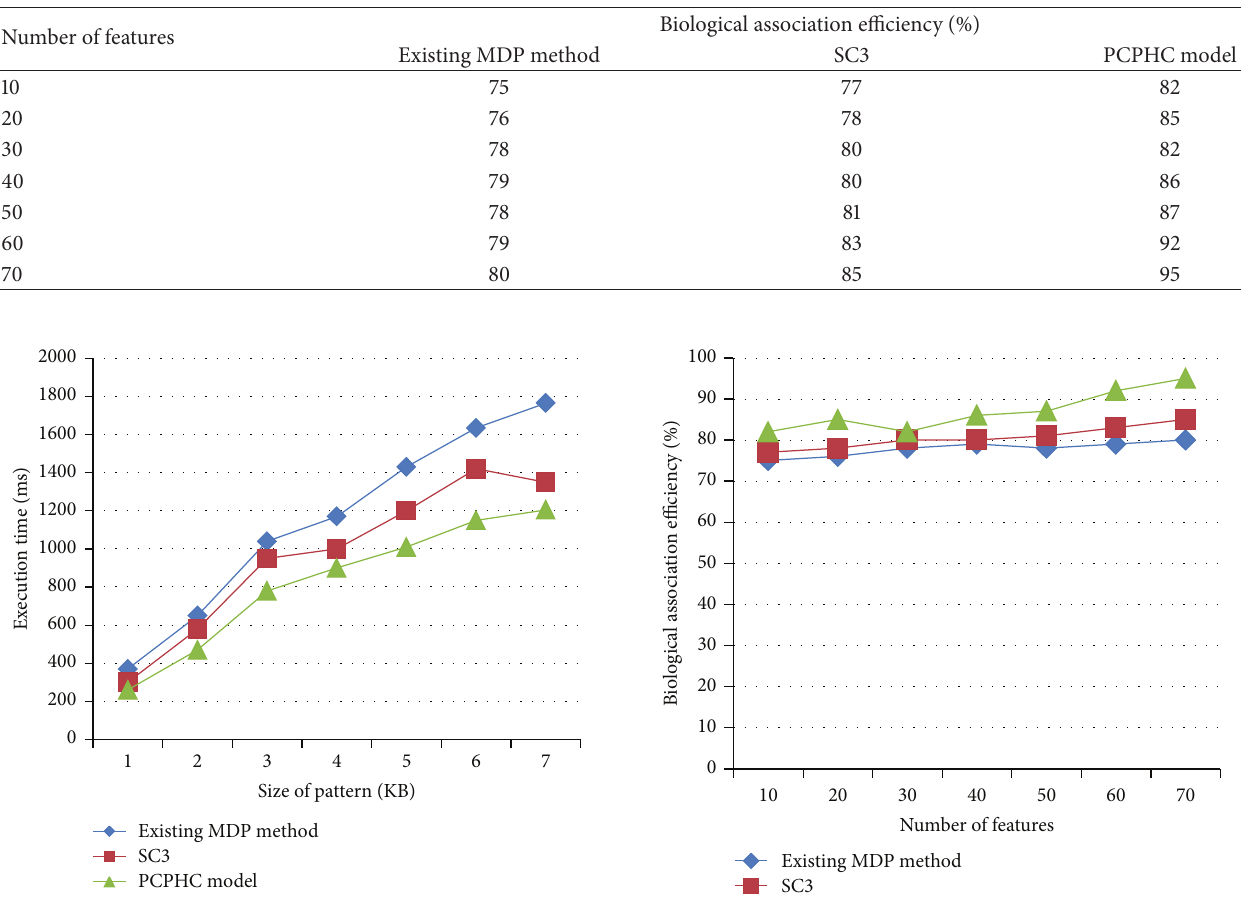
Table 2: Tabulation of biological association efficiency (using yeast gene expression dataset).